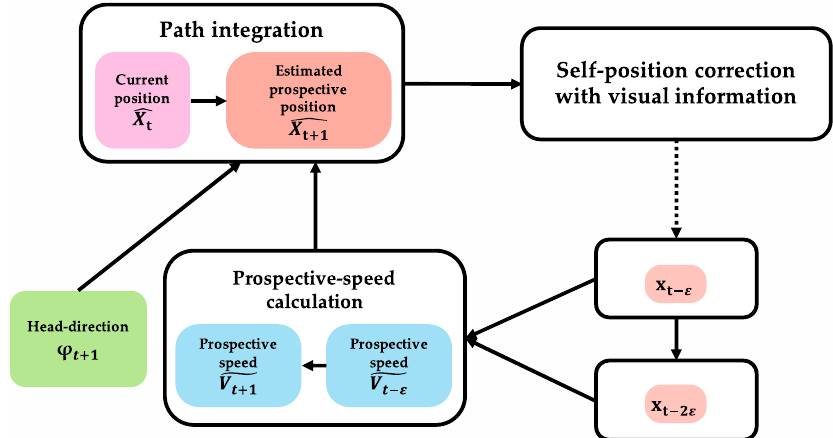
Figure 7. Path-integration algorithm to calculate prospective position. Prospective position is calculated using initial-position information and movement information. In a region where path integration is performed, there is input of movement information (head-direction information ( ϕ t + 1 ) and speed information ( V t + 1 )). Prospective-speedinformation( V t + 1 )isinputfromregionwhere prospective-speed calculation is performed. Calculation result of current position, obtained by path integration, is used as necessary initial-position information. There is a loop structure that receives position information ( X t − ε , X t − 2 ε ) corrected in the region where self-localization is performed because prospective-speed calculation uses two-position information after error correction. As a result of path integration, prospective position ˆ X t + 1 is obtained. Table 3. Required conditions for executing path-integration algorithm.